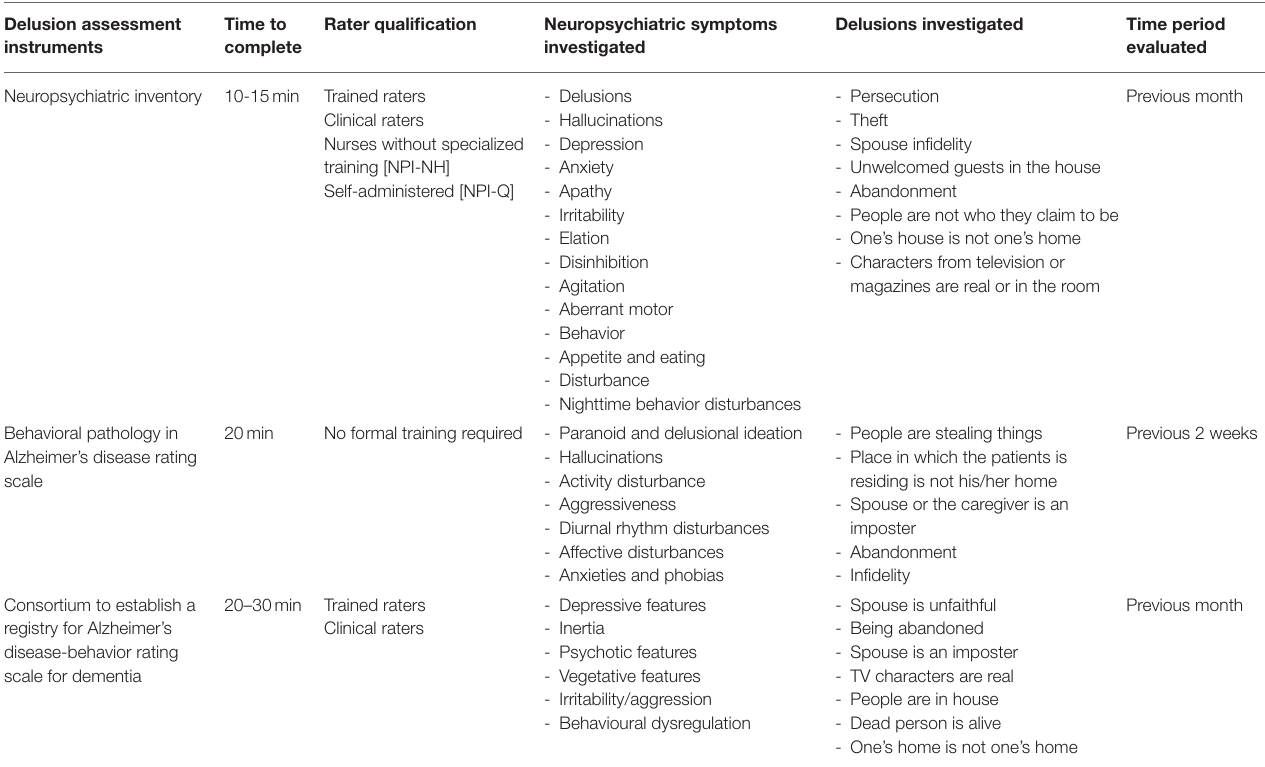
TABLE 1 | Neuropsychiatric symptoms assessment tools covering the dimension of delusion. Delusion assessment